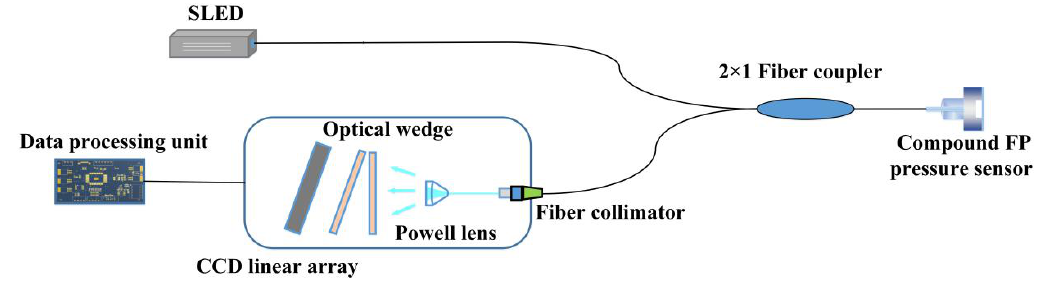
Figure 2. Schematic diagram of a white light non-scanning correlation interrogation system. The wideband light emitted by the SLED is coupled into the fiber-optic compound FP pressure sensor through the 2 × 2 fiber coupler, for the reflections at multiple surfaces of the sensor, after interferences in the basal and air cavities, part of the light is reflected back into the 2 × 2 fiber coupler. Half of the reflected light is coupled into the other fiber arm of the coupler. The light is coupled into free space as a collimated beam by a tiny fiber collimator. Then, the spatial light distribution is changed into a line-type profile by the beam-shaping of the Powell lens. The light carrying